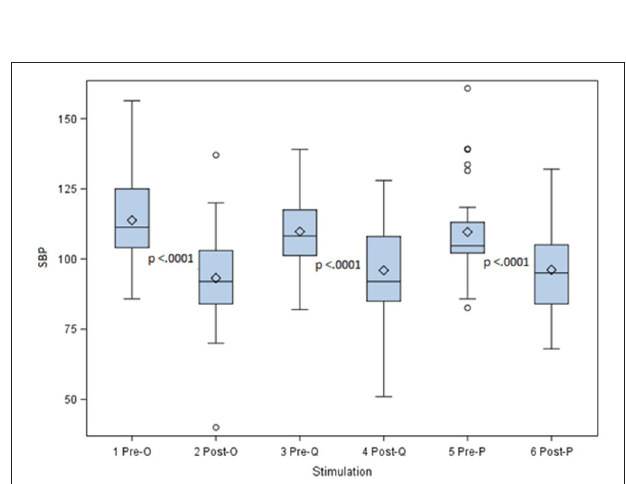
FIGURE 6 | Pre- and Post- stimulating SBP for three different stimulation probes. This figure shows the systolic blood pressure lowering for the Octad, Quad, and Pace probes. With all three stimulation probes a highly significant lowering in blood pressure was achieved with a p -value